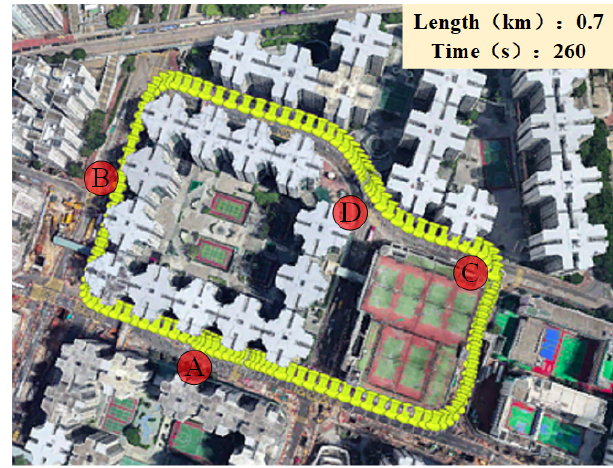
Figure 17. Complete driving environment and trajectory.